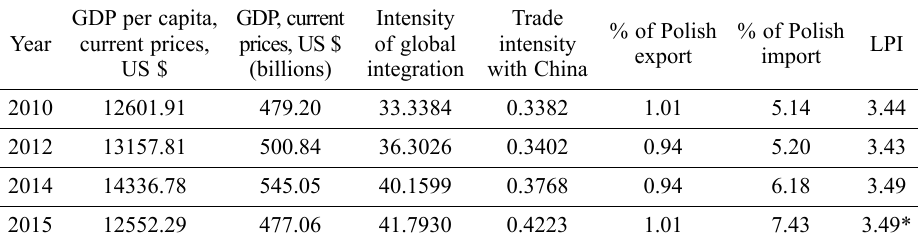
Table 1. Evaluation of the potential of Poland as a participant of the NSR 1